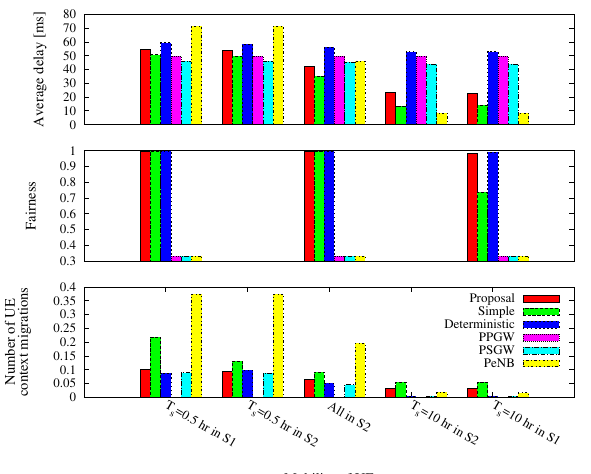
Figure 14: Results in Scenario 2 v.s. Scenario 1 ( ρ = 0 . 5